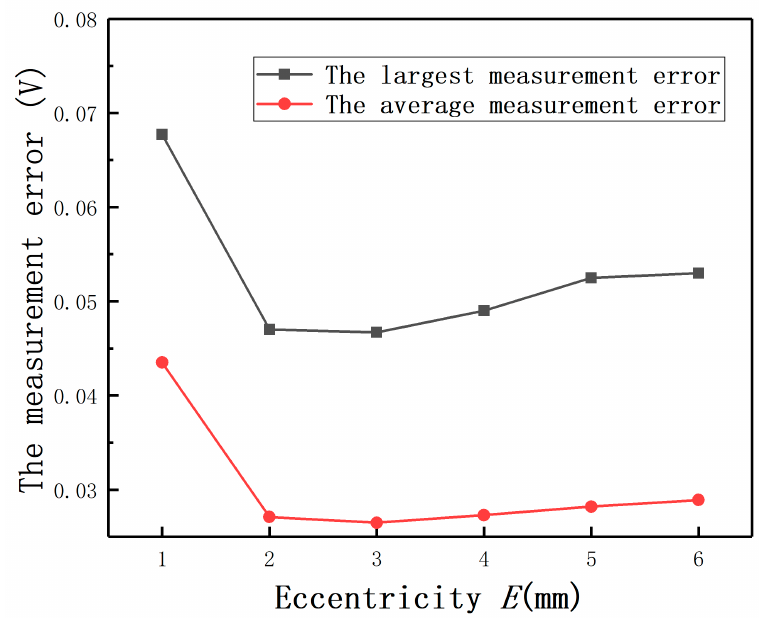
Figure 27. The largest measurement errors and the average measurement errors after compensation.